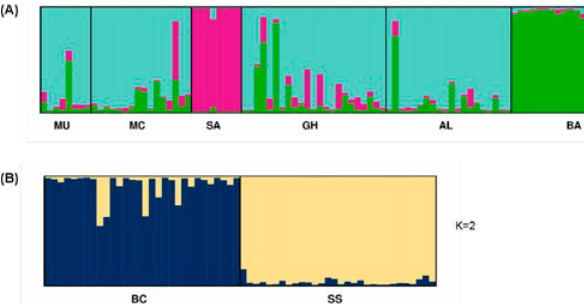
Figure 4. Proportional membership ( Q ) to clusters identified by STRUCTURE for: (A) 96 individuals from the six studied popu- lations of R. corsica; (B) 60 individuals from the two studied sub- populations of R. lamarmorae . Colours distinguish between the different clusters identified for each of the above three scenarios. Each individual is represented by a single vertical bar and grouped by locality, indicated on the x-axis. Information on each population (locality) is provided in Table